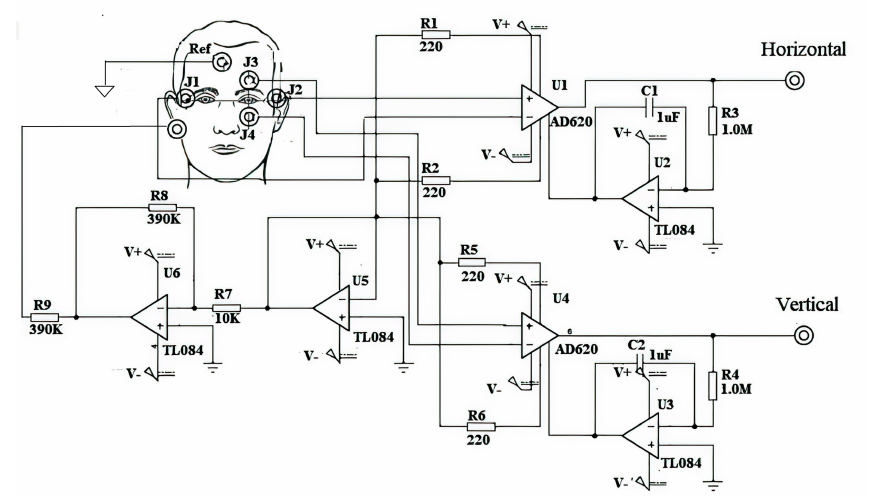
Figure 8. Amplification module and DC elimination module. It is implemented using an AD620 Instrumentation Amplifier with a CMRR greater than 100 dB, to remove the DC level an Integrator circuit is used for feedback concerning the EOG signal at the reference terminal of the